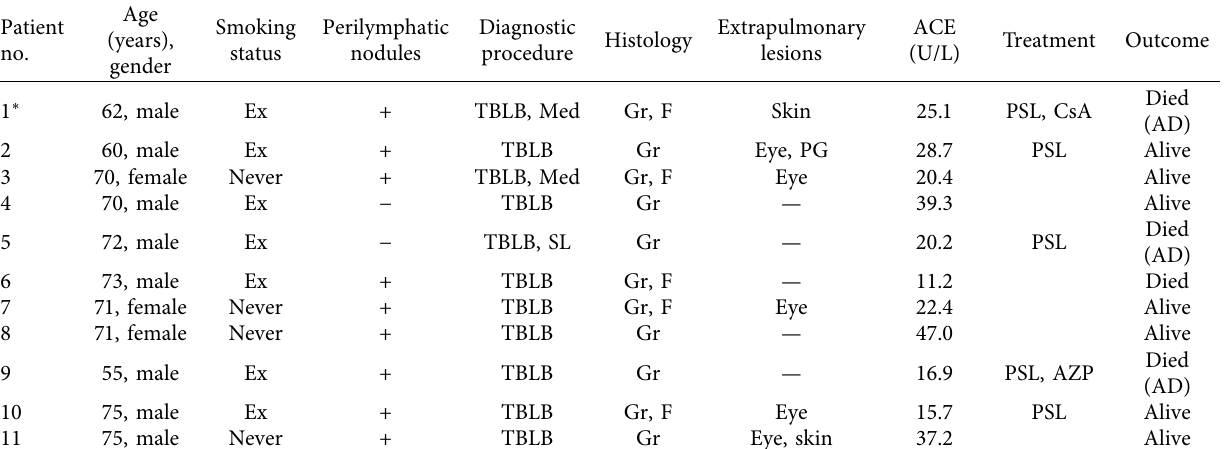
Table 2: Clinical characteristics in patients with lower lung-dominant sarcoidosis.